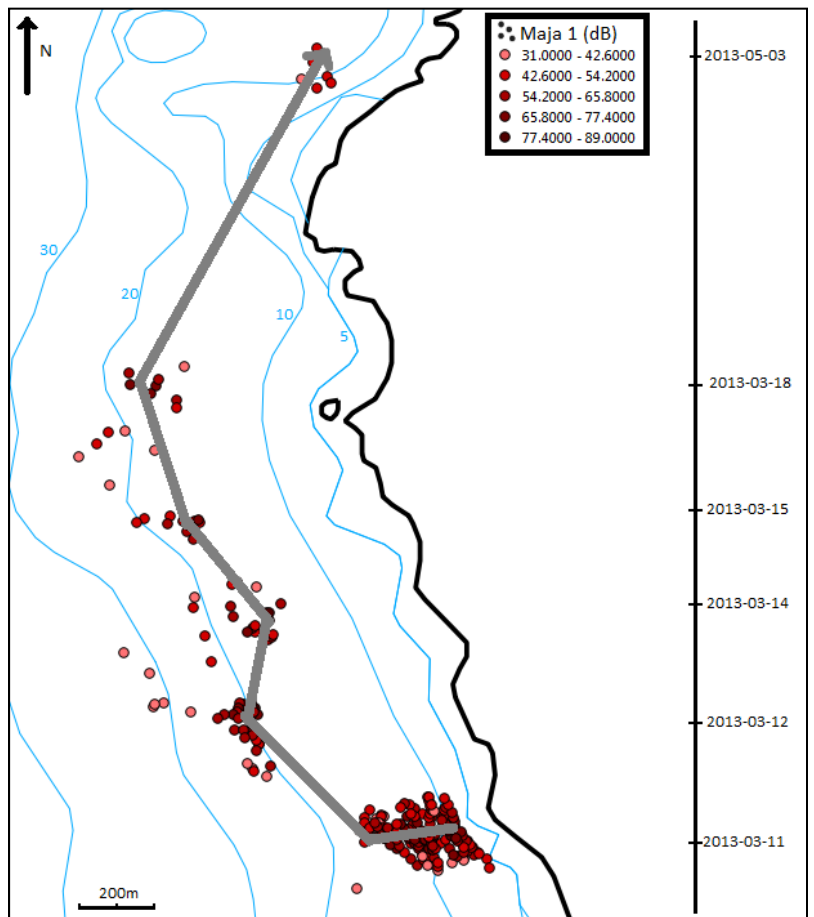
Figure 6. Trajectory of Maja 1 during the experimental